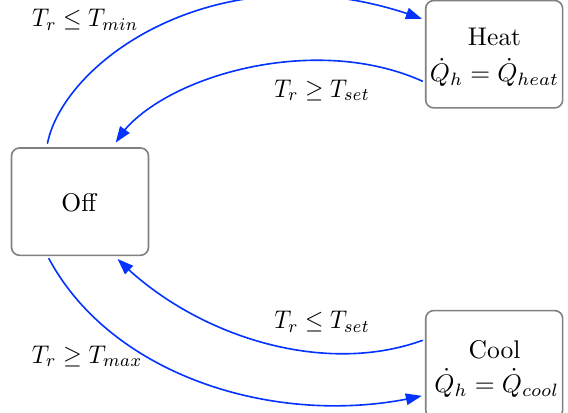
Figure 3. State transition diagram of the HVAC control